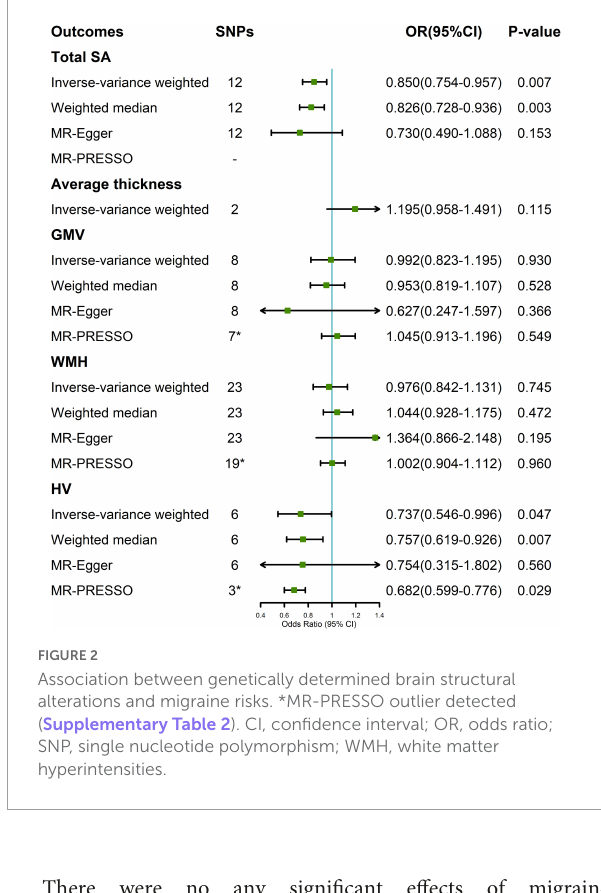
There were no any significant effects of migraine on brain structural alternation in the reverse estimates ( Supplementary Table 3